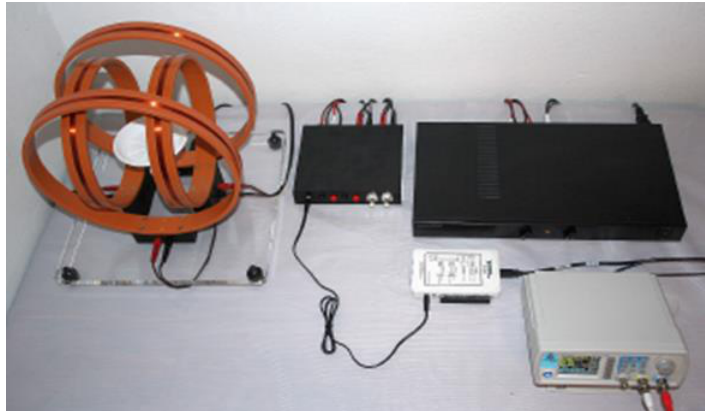
Figure 2. View of the overall set-up (own study)